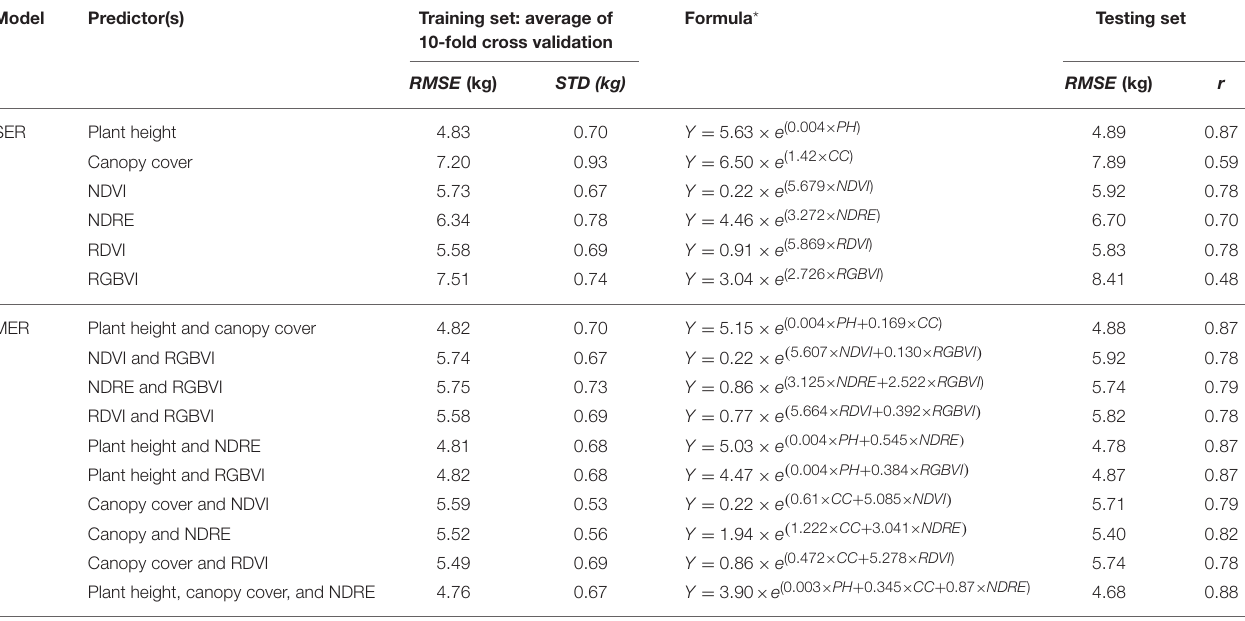
TABLE 5 | Dry biomass estimation results in 10-fold cross validation as well as in the testing set, based on simple exponential regression (SER) and multiple exponential regression (MER) model. Model Predictor(s) Training set: average of Formula * Testing 10-fold cross validation